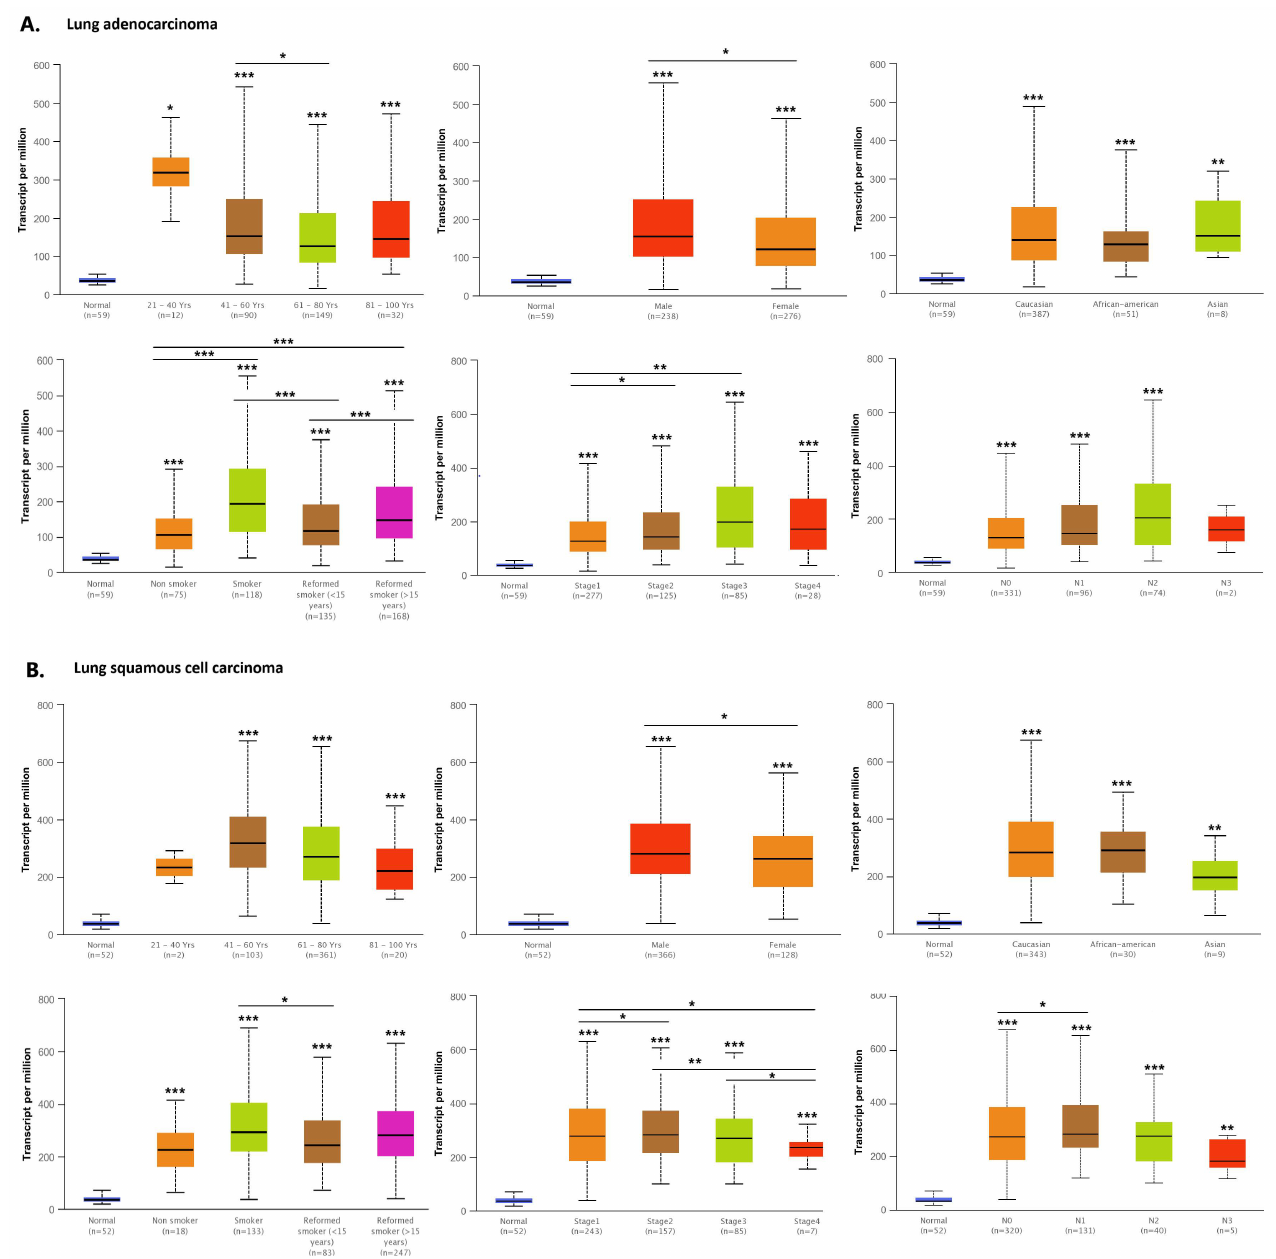
Figure 12. Association between the HMGA1 expression level and selected clinical parameters: age, gender, population affinity, smoking status, TNM stage, and nodal involvement in healthy individuals and lung cancer patients. ( A ) lung adenocarcinoma patients. ( B ) lung squamous cell carcinoma patients (UALCAN); * p < 0.05, ** p < 0.01, *** p < 0.001; the first layer-* right above the error bar indicates comparison to the normal group, the above layers-* placed above a second line indicates the comparison between corresponding groups covered by the